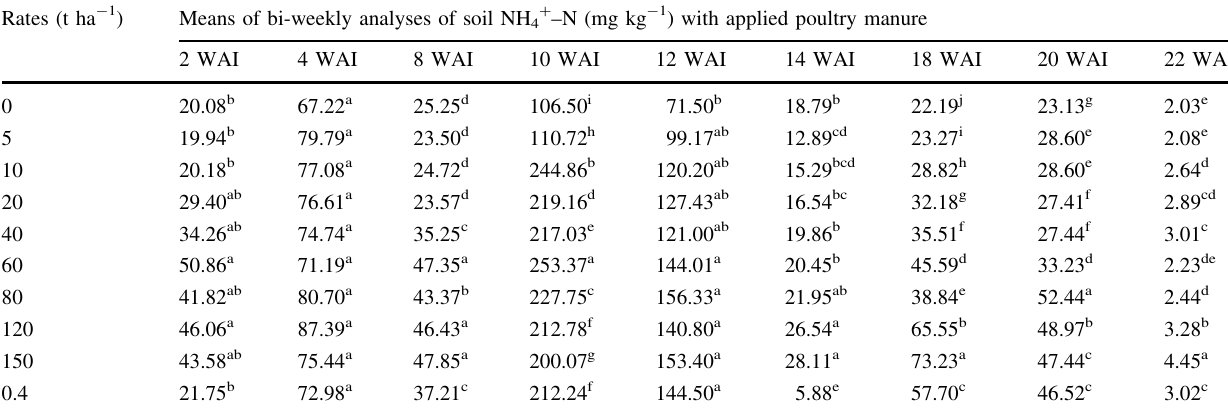
Table 7 Influence of poultry manure rates and NPK fertilizer (t ha - 1 ) on mean soil NH 4 ? –N (mg kg - 1 ) at 2 weeks intervals Rates (t ha - 1